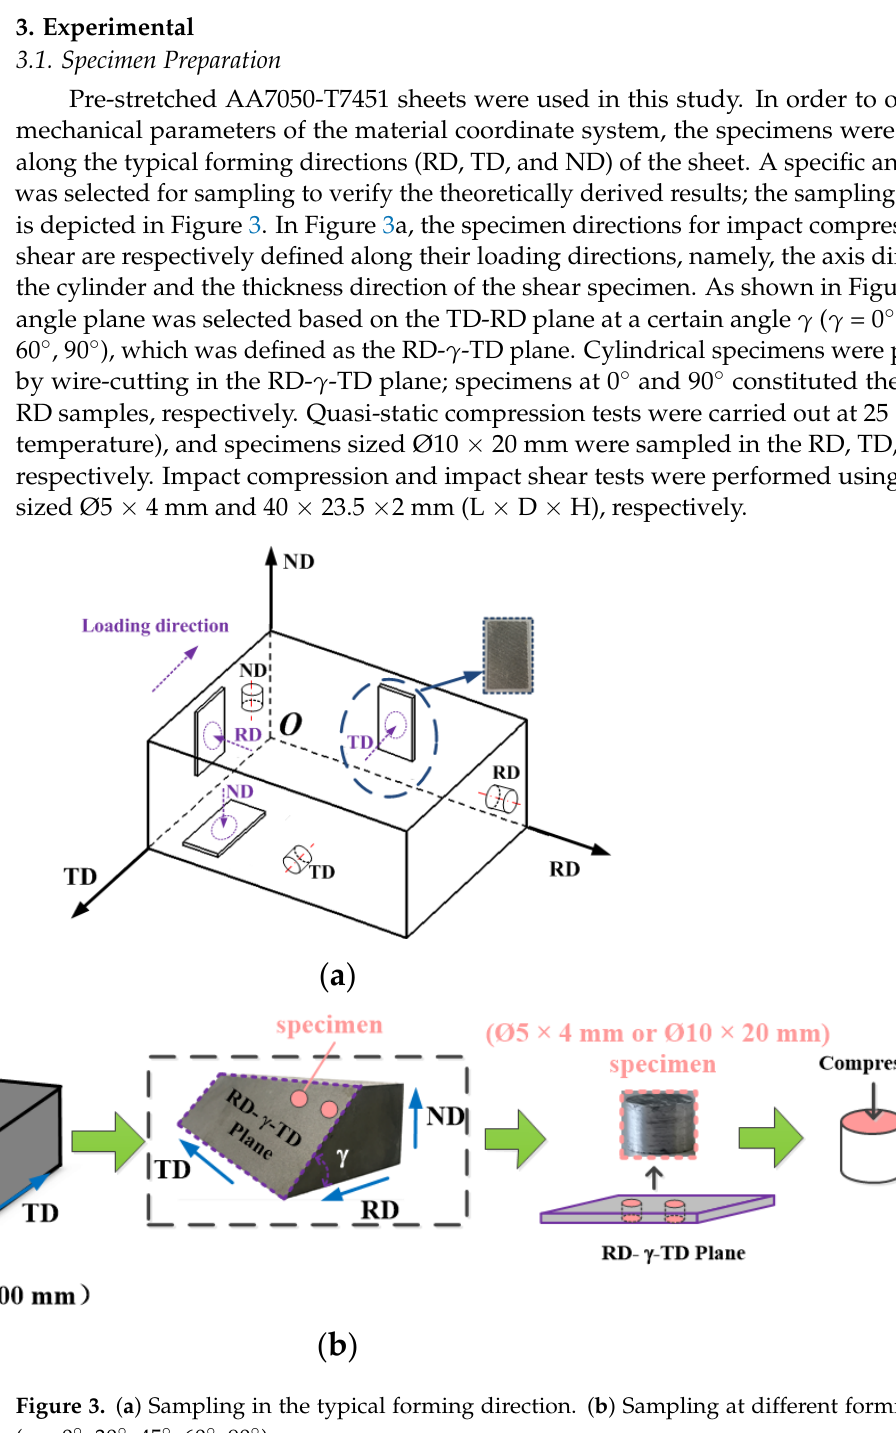
Figure 3. ( a ) Sampling in the typical forming direction. ( b ) Sampling at different forming angles ( γ = 0°, 30°, 45°, 60°, 90°).